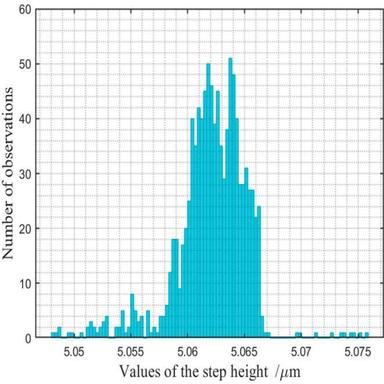
Distributions of the values of the step height computed by the ISO based method in Experiment 2.